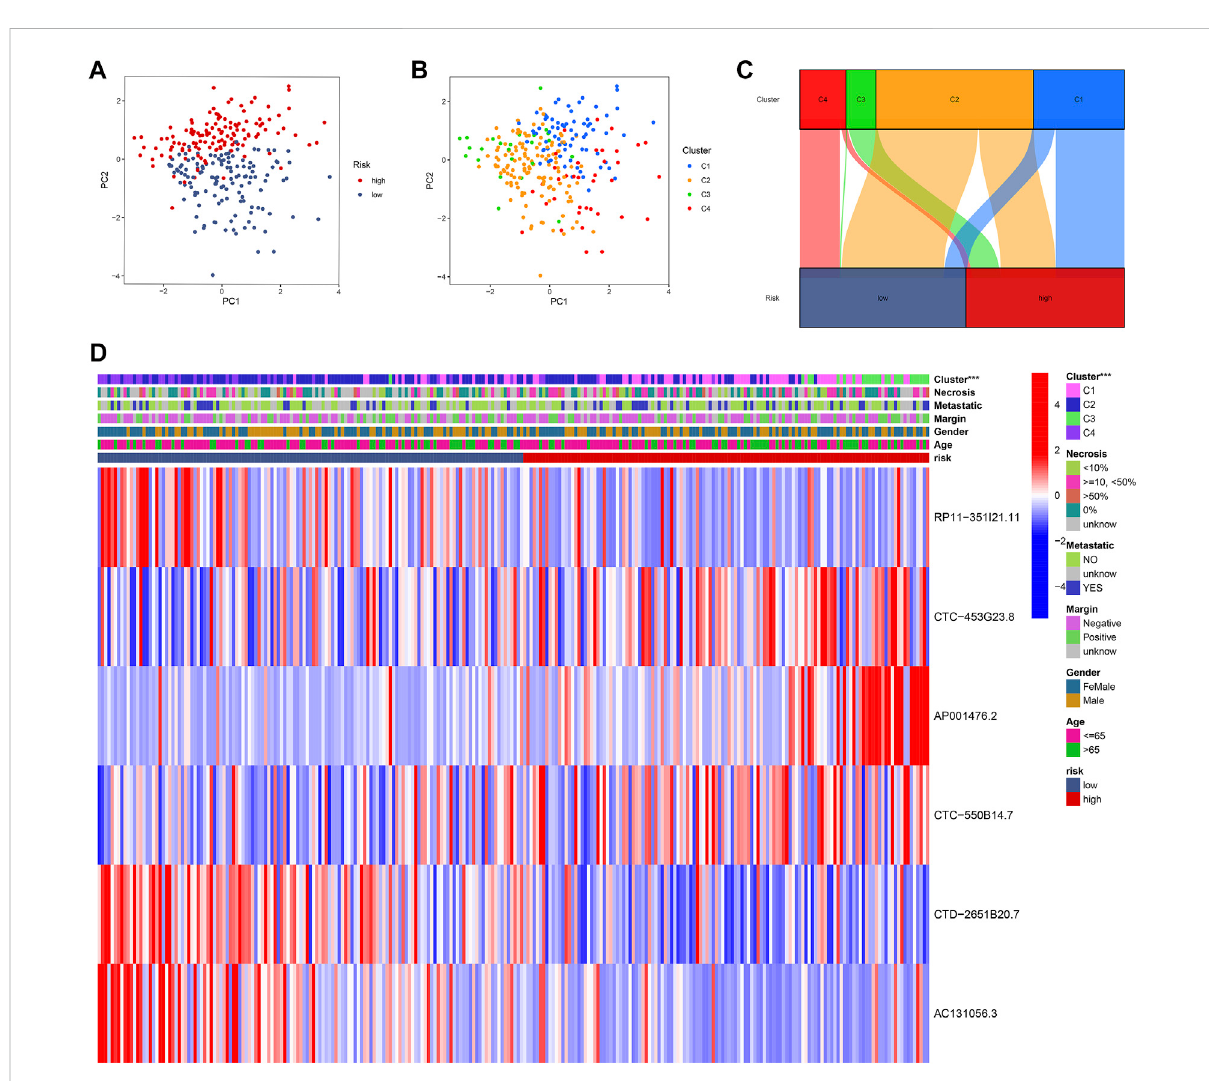
FIGURE 7 Intrinsic crosstalk between CuLncScore model and cuproptosis lncRNA clusters. Principal component analysis (PCA) plots of patients with expression pro fi les in different risk groups (A) and clusters (B) . (C) Cross-connection of patients in distinct risk groups and clusters. (D) Heat map of clinical characteristics of two risk groups and four clusters. *** p <